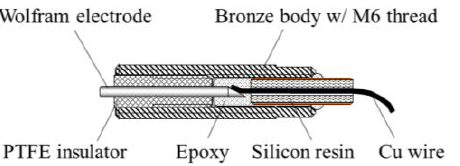
Figure 9. Schematic of the ion sensor for registering detonation waves in RDEs.